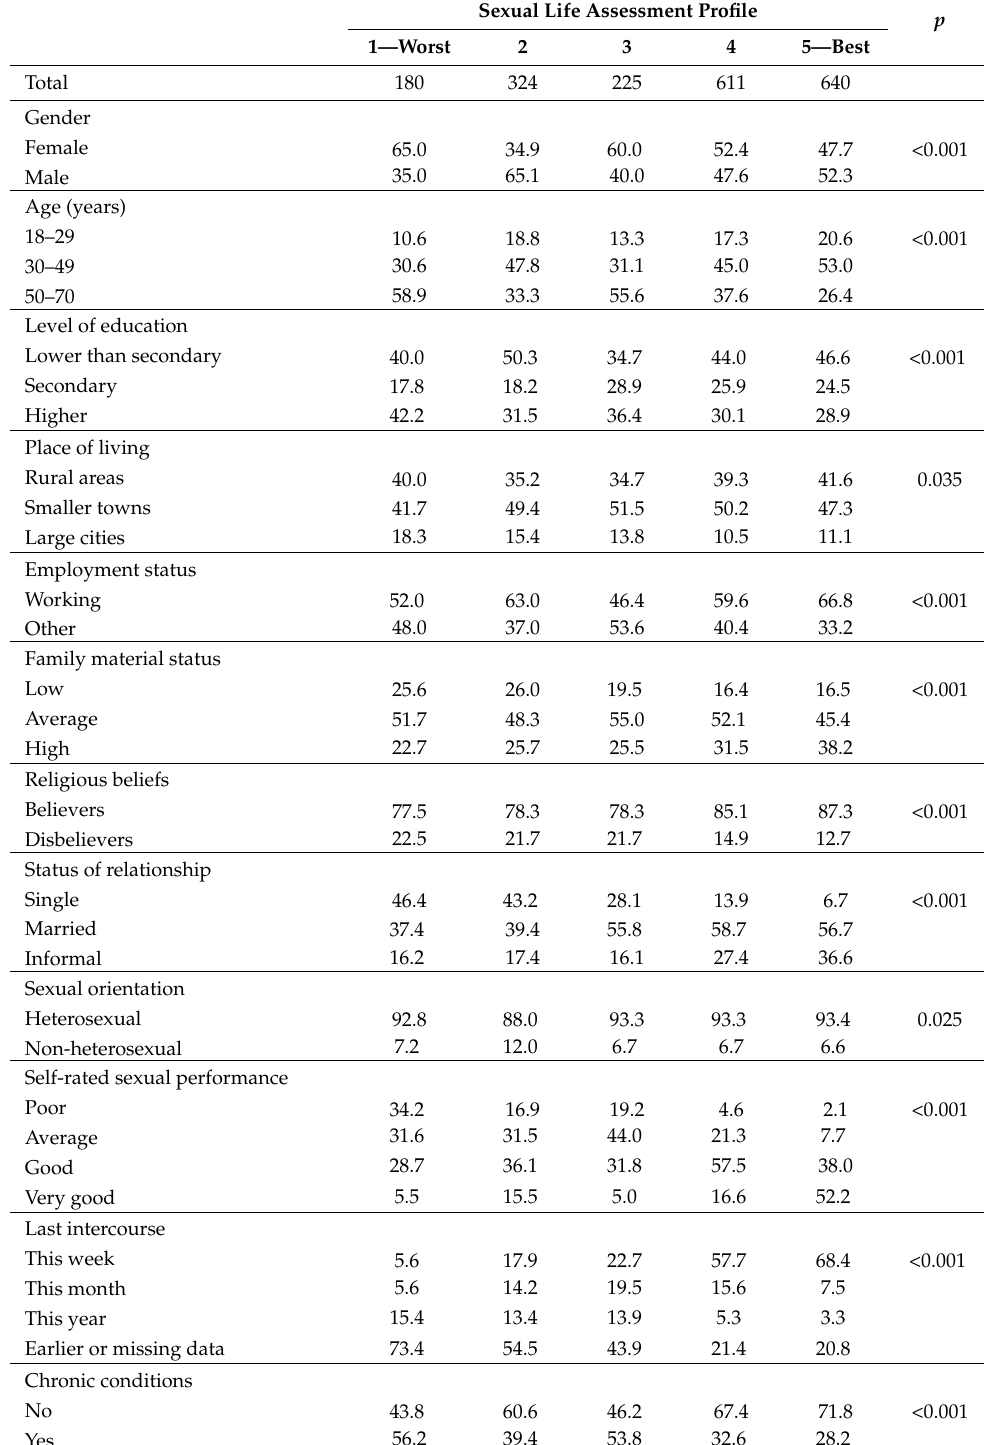
Table A1. Characteristics of sexual life assessment profiles in